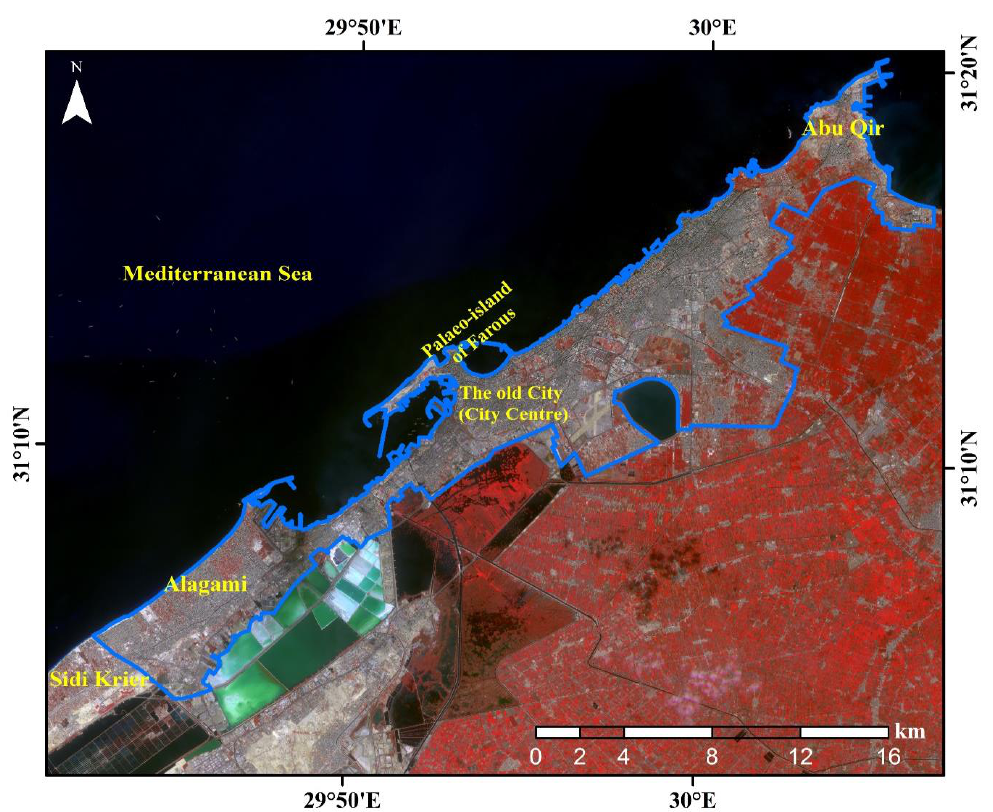
Figure 2. Study area. Based on a background of a Sentinel-2 (S-2) infrared false color image acquired on 24 October 2018 (R: band 8, G: band 4, B: band 2), Figure 2 presents the study area with blue border, and main city areas names wrote in yellow color font. The S-2 infrared false color image shows vegetation in reddish colors, built-up areas in grayish colors, and salty swamps in greenish colors.